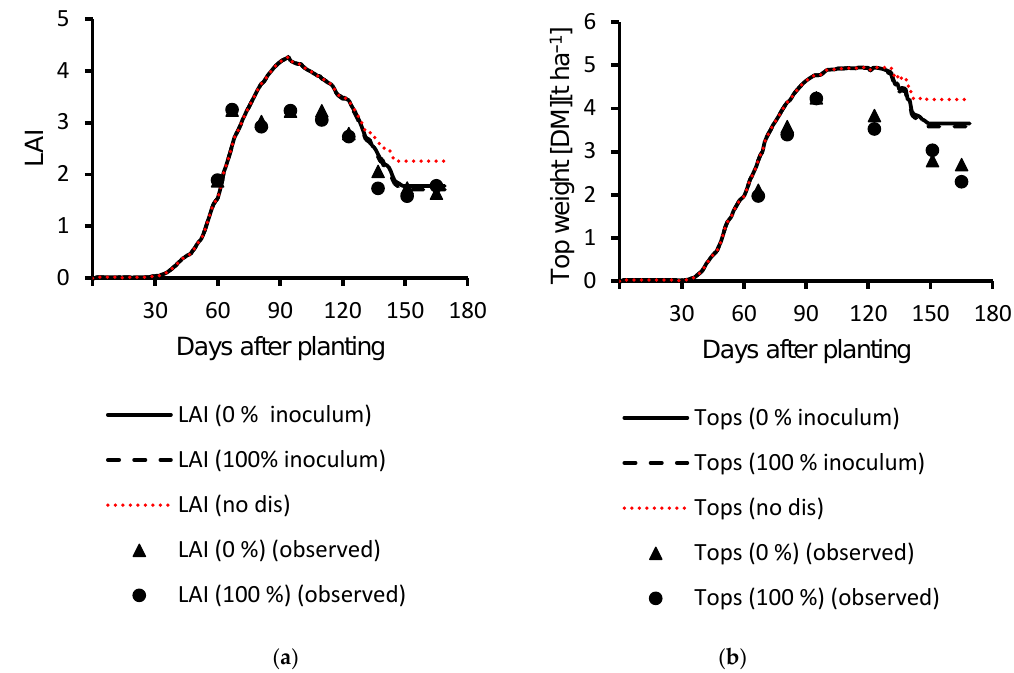
Figure 11. Simulated and observed values with Cercospora leaf spot ratings included in simulation results: ( a ) LAI; ( b ) top weight (DM t ha −1 ) for the evaluation treatment with sugar beet growth simulated with current genetics and without Cercospora leaf spot disease ratings being included in the simulation process as “no dis” treatment.